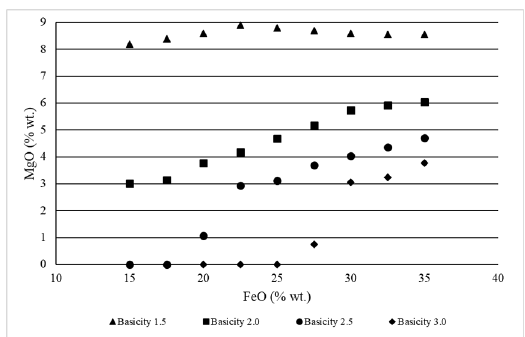
-FeO pseudo-ternary diagram at 5% MgO Figure 4. CaO-SiO 2 and T = 1600°C.